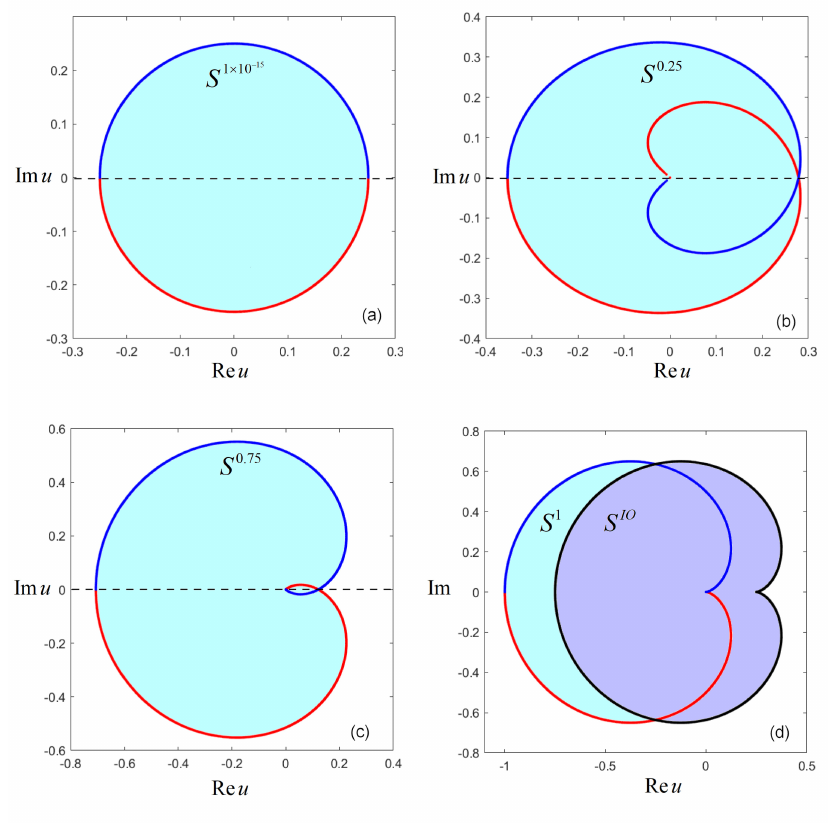
Figure 3. Local asymptotic stable regions S q of fixed points (4) and of the fixed point of the Mandelbrot asymptotic stable region of the Mandelbrot map of integer order S IO